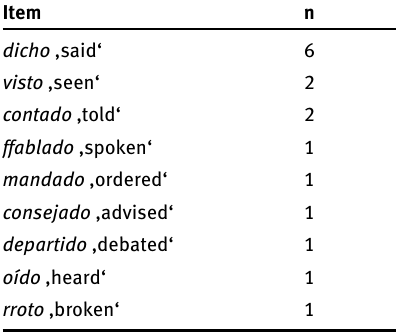
Table 1. First occurrences of the perfecto compuesto quantified by iterative muchas vezes ‘many times’ (13 th